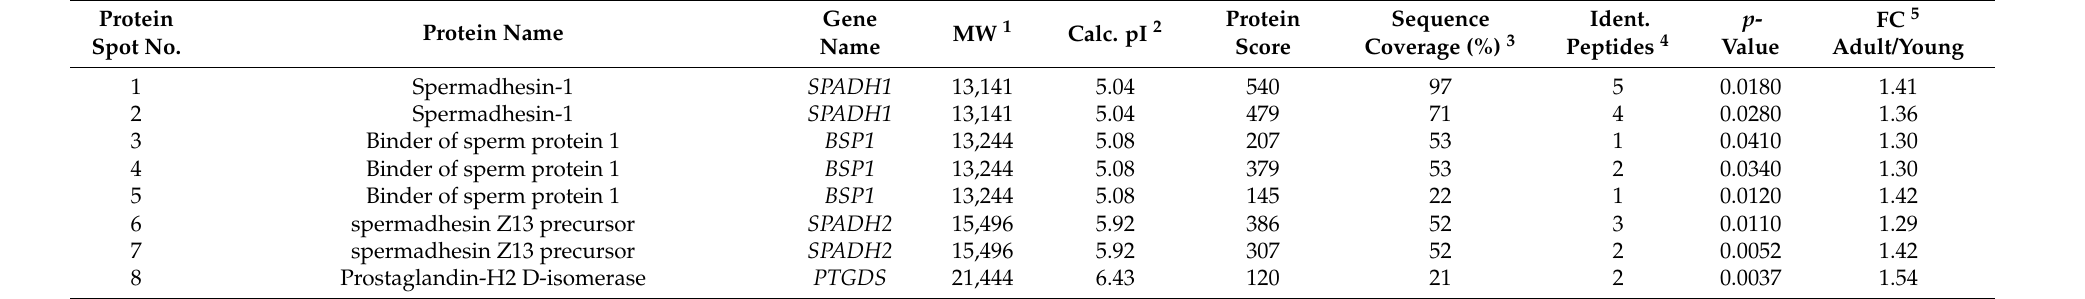
Table 3. Proteins changing in supernatant of thawed sperm of adult bulls in comparison to young bulls.